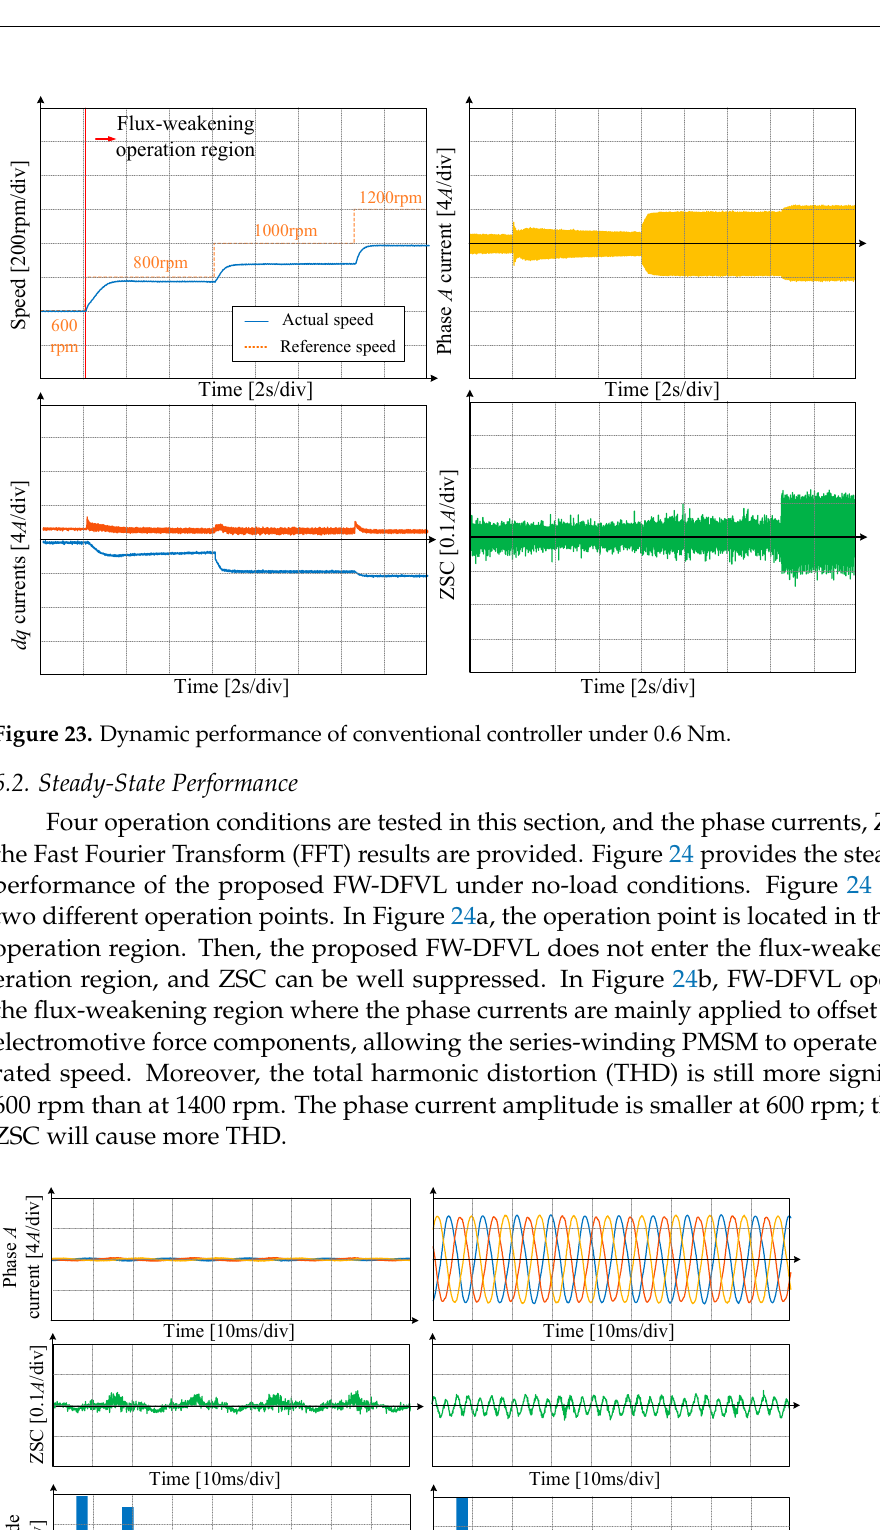
Figure 22. Overmodulation dynamic performance of FW-DFVL under 0.6 Nm.